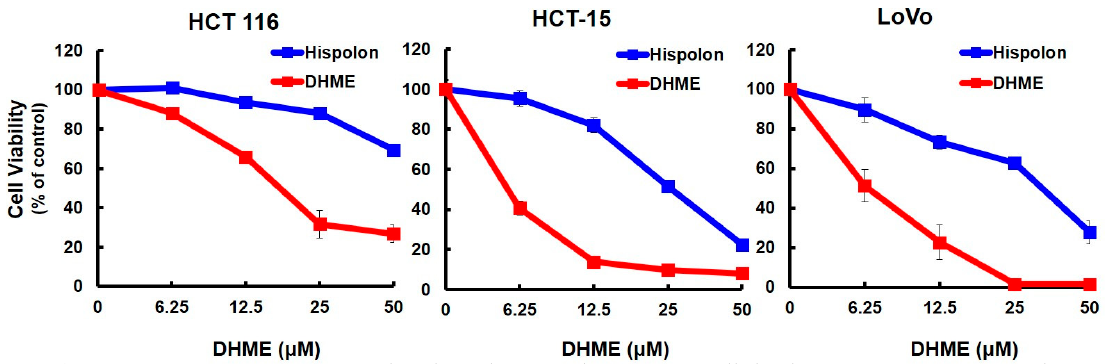
Figure 2. DHME is more potent than hispolon in inducing CRC cell death. HCT 116, HCT-15, and LoVo cells were treated with indicated concentration (0.00, 6.25, 12.50, and 50.00 μ M) of hispolon